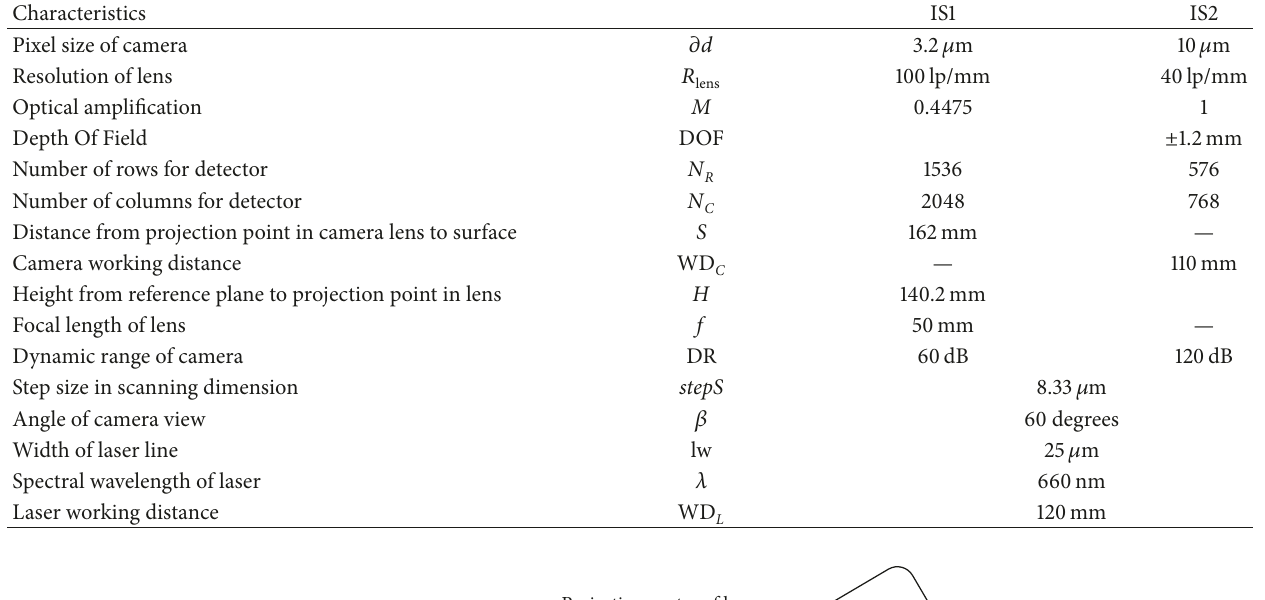
Table 1: Properties of scanner system and its components.